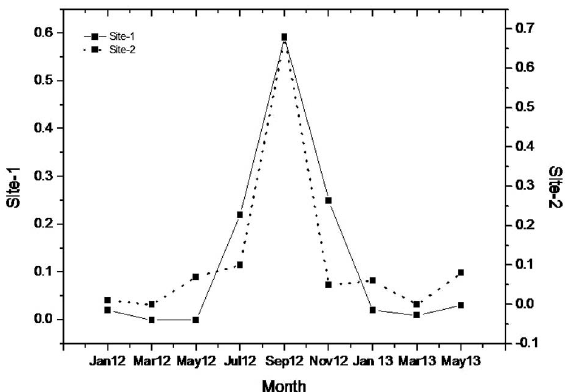
Fig. 11. – Protein/carbohydrate ratio at Site 1, Payyannur (PNR) and Site 2, Panambur